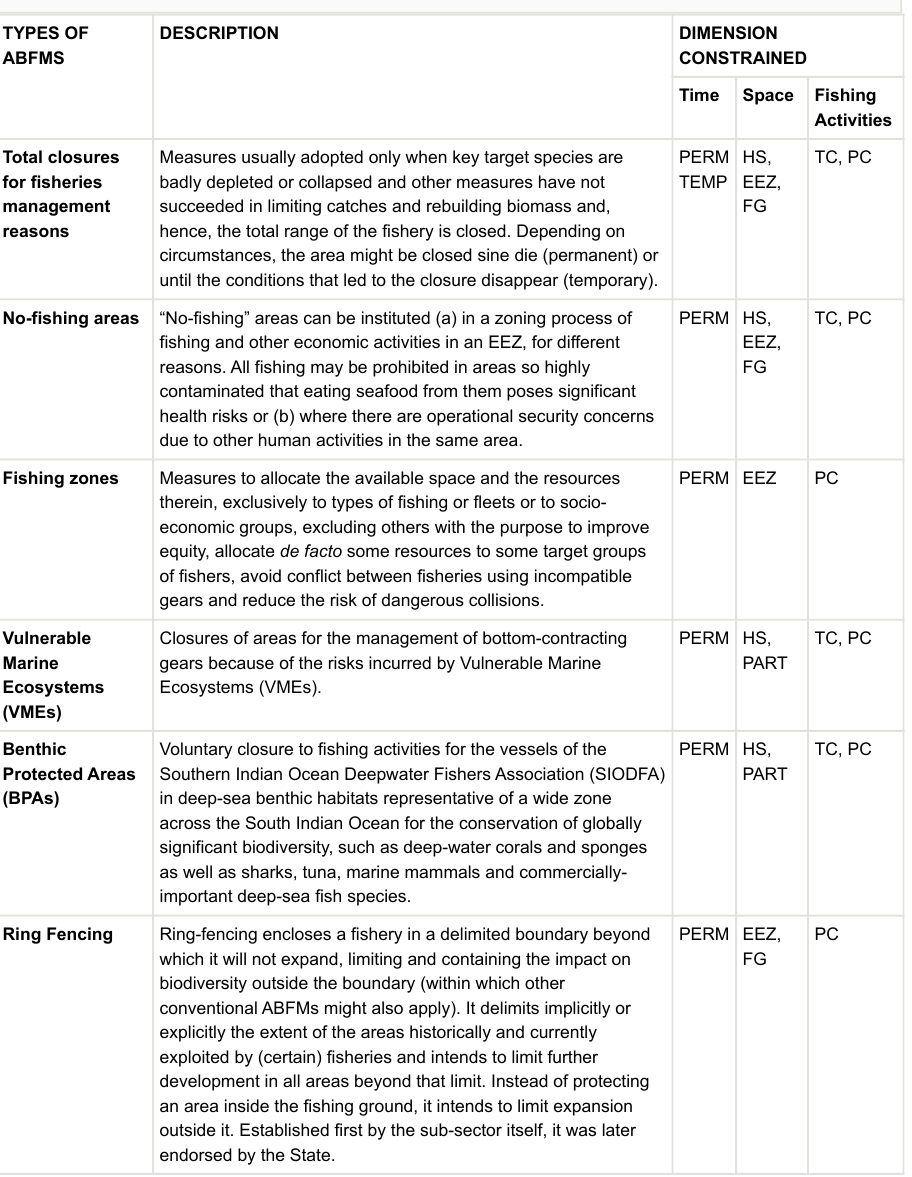
Main types of Area-Based Fishery Management Measures (ABFMs) and their constraints in space, time and fishing activities as proposed by Rice et al. (2018) and their description as summarised for the purposes of the current study. Time: PER Μ = permanent; TEMP= temporal; SEAS=seasonal; RT= real time. Space closed: HS= High Sea, EEZ=exclusive economic zone; FG= fishing ground; PART= partial. Fishing Activities: TC= total closure; PC= partial closure.